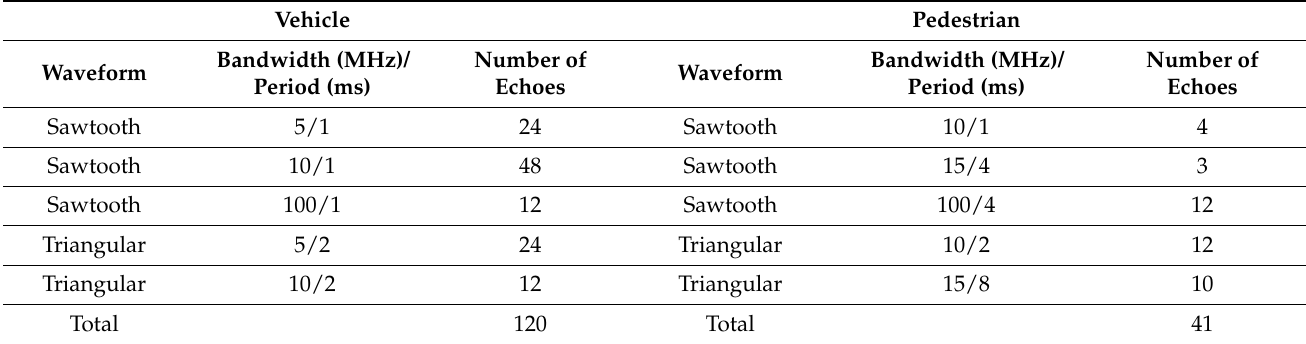
Table 2. Parameters of measured